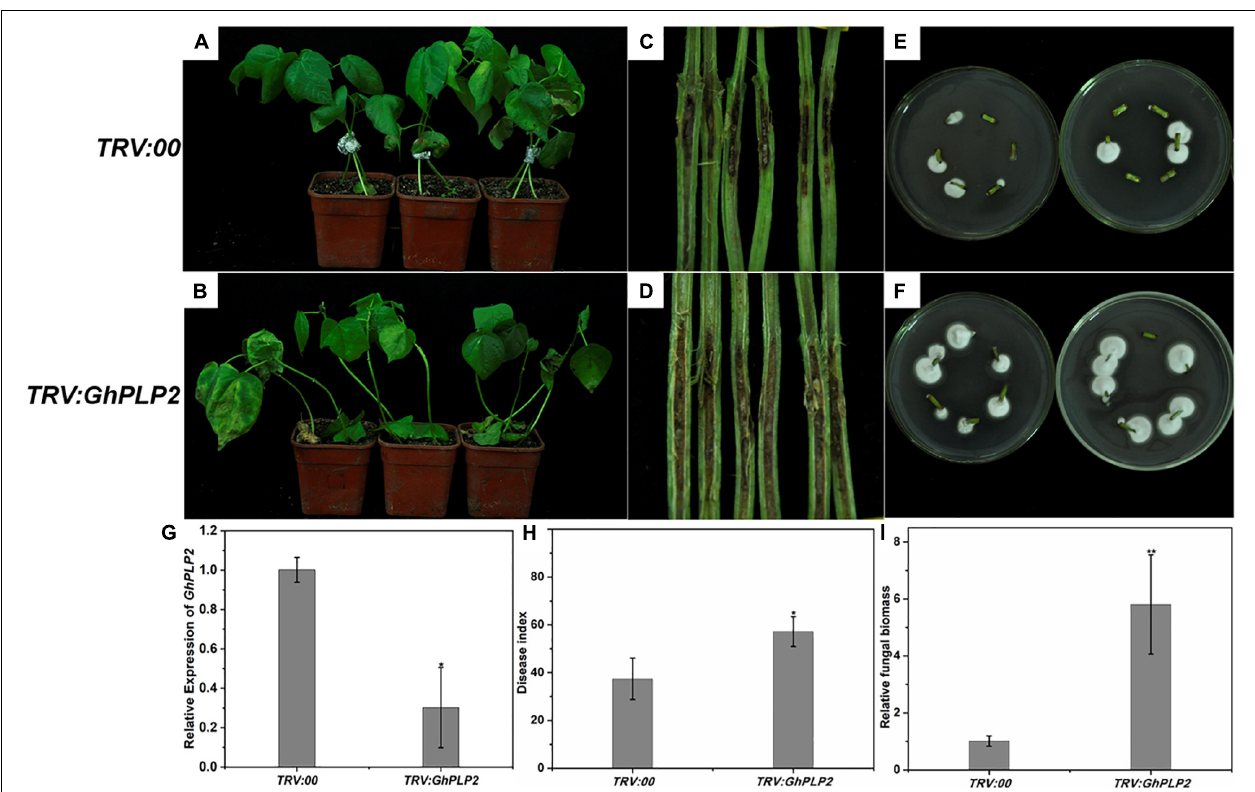
FIGURE 5 | Attenuated resistance of GhPLP2 -silenced cotton plants to Verticillium dahliae . Disease phenotypes of the control (A) and GhPLP2 -silenced cotton plants (B) inoculated with V. dahliae at 14 days. Vascular browning in the stems of control (C) and GhPLP2 -silenced cotton plants (D) infected by V. dahliae at 21 days. The fungal renewal cultivation of control (E) and GhPLP2 -silenced cotton plants (F) infected by V. dahliae at 21 days. (G) The VIGS efficiency of GhPLP2 was evaluated by qRT-PCR after 2 weeks. Data were obtained from three independent biological replicates. Asterisks indicate a significant difference compared with the TRV:00 . (H) The disease index of control and GhPLP2 -silenced cotton plants inoculated with V. dahliae at 14 days. Data were obtained from three independent technical replicates. Asterisks indicate a significant difference compared with TRV:00 . (I) Relative fungal biomass of the control and GhPLP2 -silenced cotton plants infected by V. dahliae at 21 days. Data represent the means ± standard error of three independent biological replicates. Asterisks indicate a significant difference compared with TRV:00 . ( *P < 0.05, **P < 0.01, Student’s t